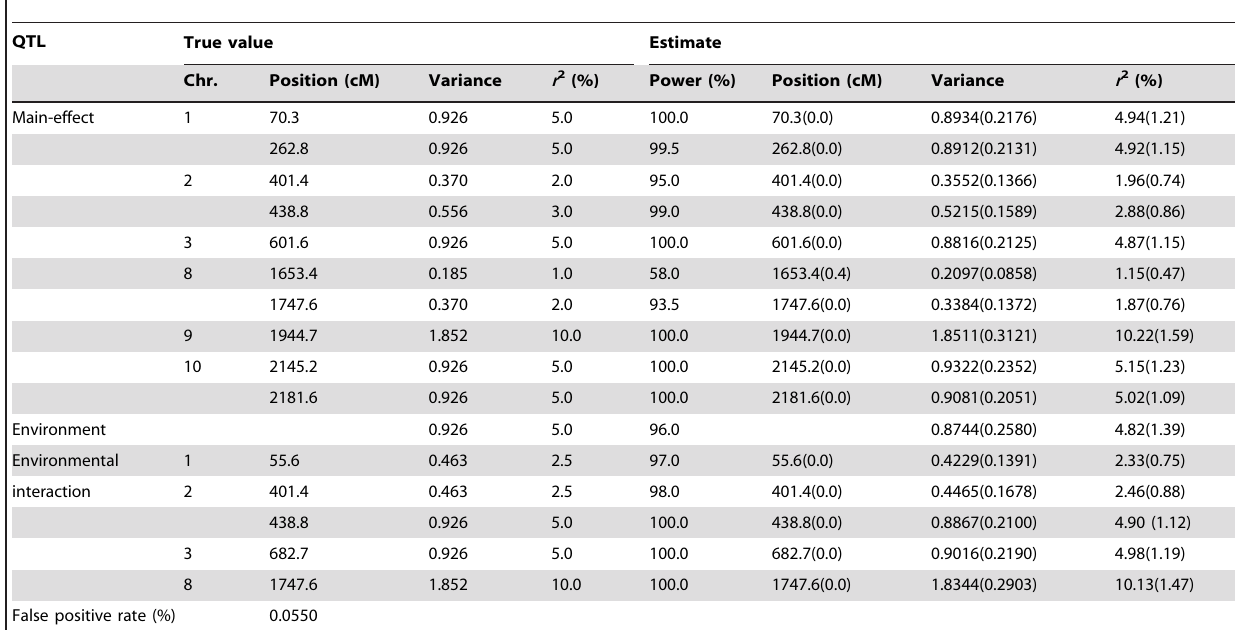
Table 3. Environmental interaction detection in Monte Carlo simulation experiment (200 replicates).